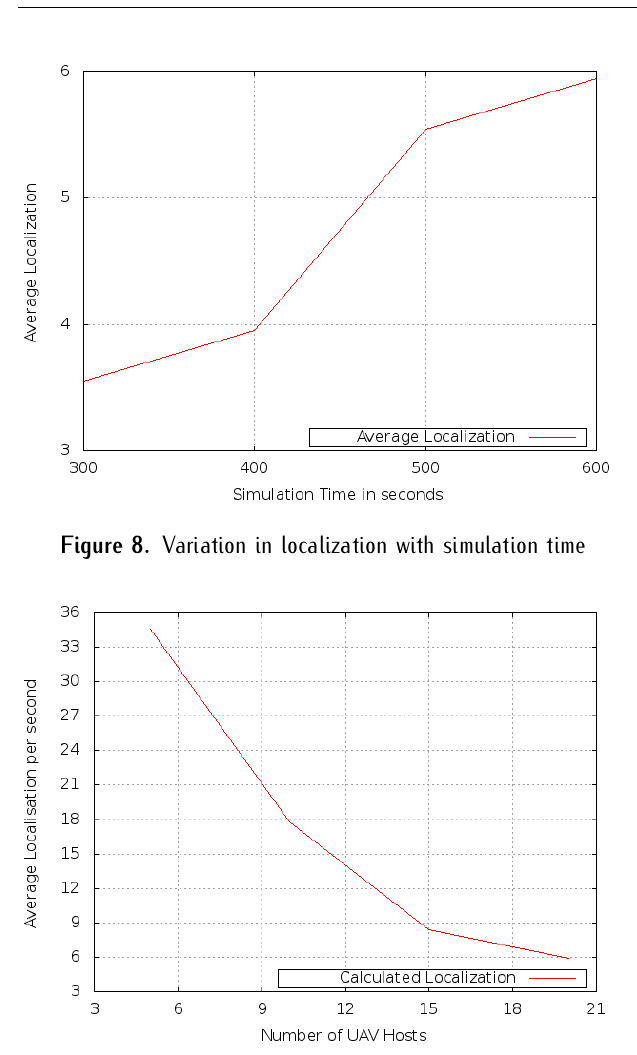
Figure 9. Variation in localization with number of hosts to variation in di ff erent parameters, using the average error as a indication of correctness. The average error is obtained by calculating the distance between actual UAV position and the calculated position, and taking an average over the whole simulation.